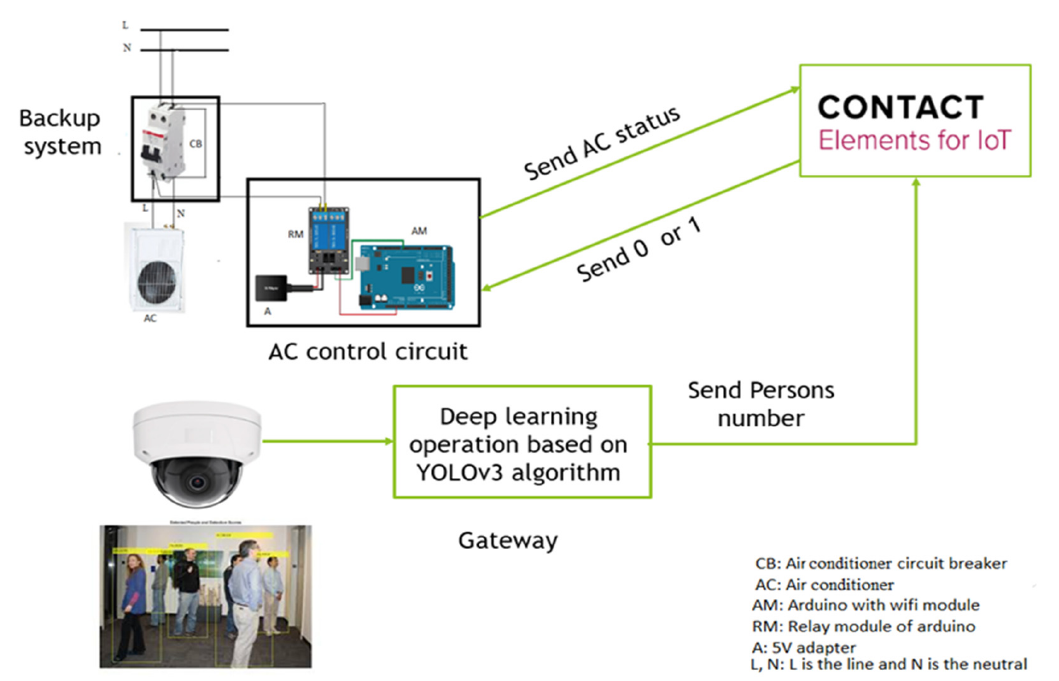
Figure 9. Air conditioner energy control circuit based on deep learning and IoT.